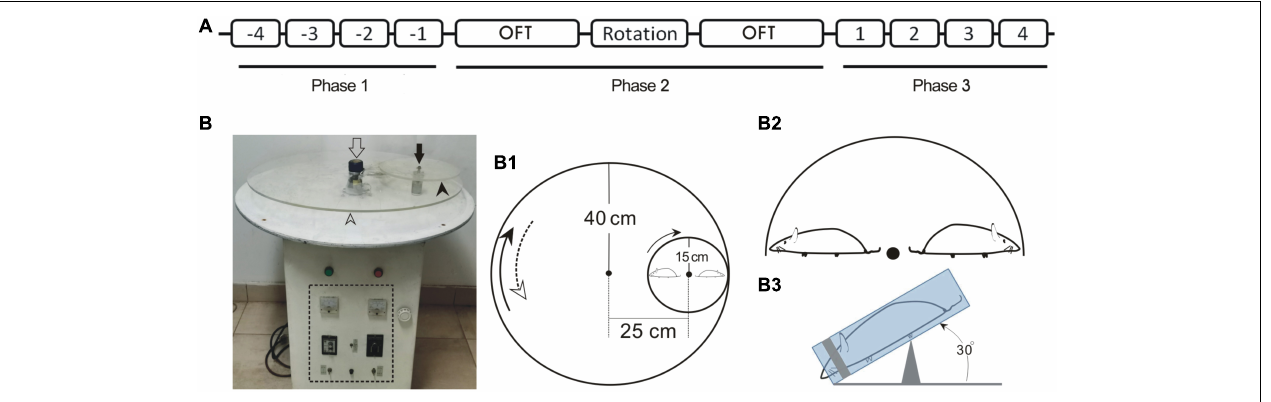
FIGURE 1 | Schematic drawing depicting the timing for animal treatments in behavior test (A) , the prototype of MS rotator (B) and the construct of main mechanical working parts in association with animal positioning (B1–B3) . (A) Numbers -4 – -1 or 1–4 indicate the first to fourth full days in Phase 1 and Phase 3, respectively. (B) Prototype of the motor-driven double-axis rotation device for provoking MS. The open and filled arrows indicate the axes of large (open arrowhead) and small (filled arrowhead) turntables, respectively. The dashed line box demarcates the control panel area. (B1) Assemblage of the big and small turntables of the MS rotator. The measurements for radii and the distance between axes are denoted. (B2) Configuration demonstrating the radially oriented rats in relation to the small turntable. (B3) Lateral view of the positioning of restrained rat with anteroposterior axis tilted at an angle of 30 ◦ . OFT, open field